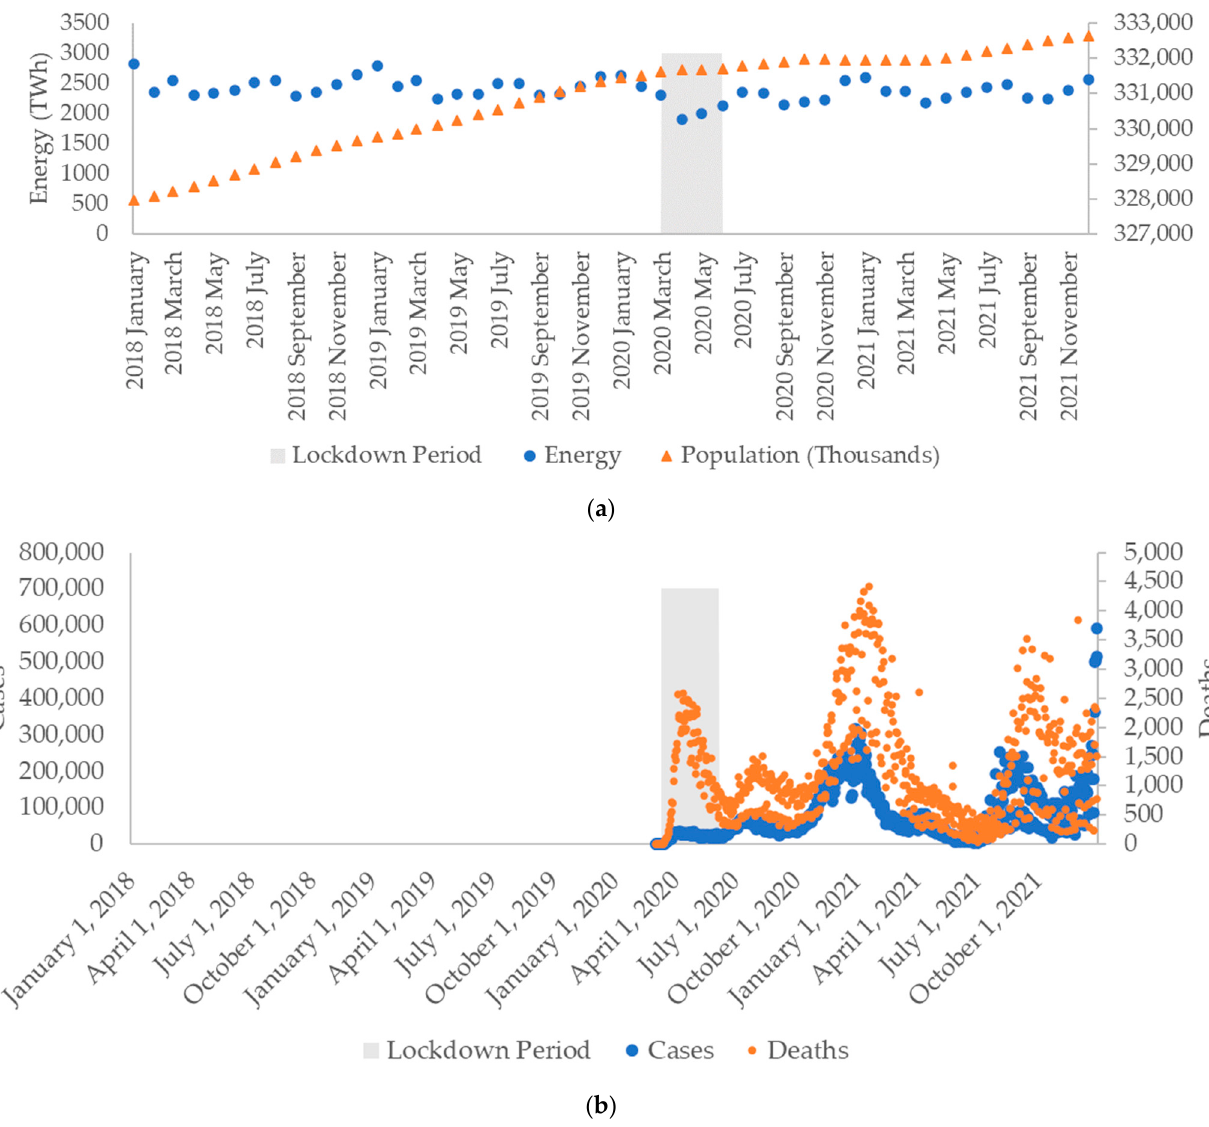
Figure 4. Monthly US COVID pandemic data 2018–2021: ( a ) population and total energy consump- tion; ( b ) cases and deaths [25,26,28,29].